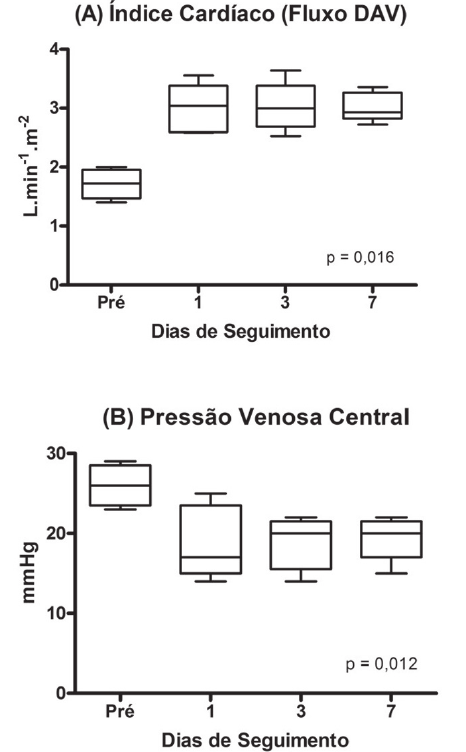
Fig. 4 - Valores do fluxo mantido através do dispositivo de assistência ventricular esquerda (A) e da pressão venosa central (B), durante a assistência circulatória nos cinco